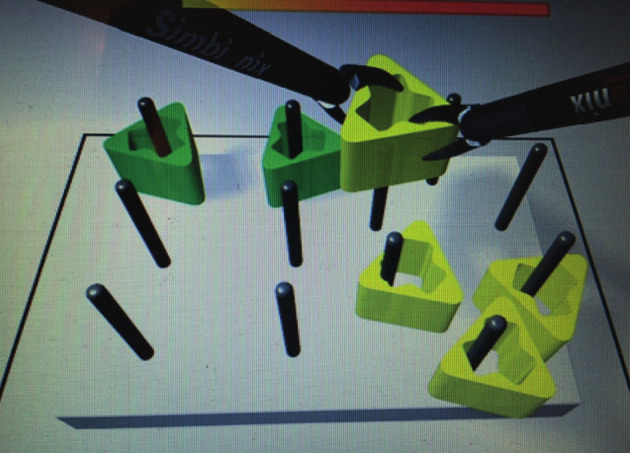
— Task 2. Peg transfer.